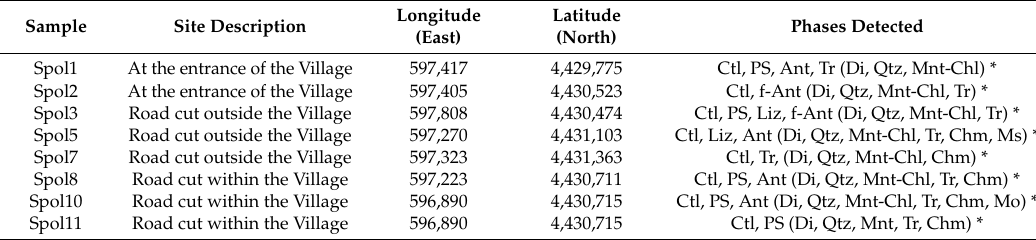
Table 1. Studied localities, reference coordinates and, for each collected soil sample, mineralogical assemblage detected by X-ray powder diffraction (XRPD) and by scanning electron microscopy combined with energy dispersive spectrometry (SEM-EDS) * after [30]. Serpentine minerals varieties and amphiboles detected by DSC, DTG and TEM-EDS. Chlorite (Chl), chrysotile (Ctl), polygonal serpentine (PS), lizardite (Liz), fibrous antigorite (f-Ant), antigorite (Atg) and tremolite (Tr) (mineral symbols after Whitney and Evans [39]). Amphiboles present in the samples were classified according to the amphibole diagram classification [40].